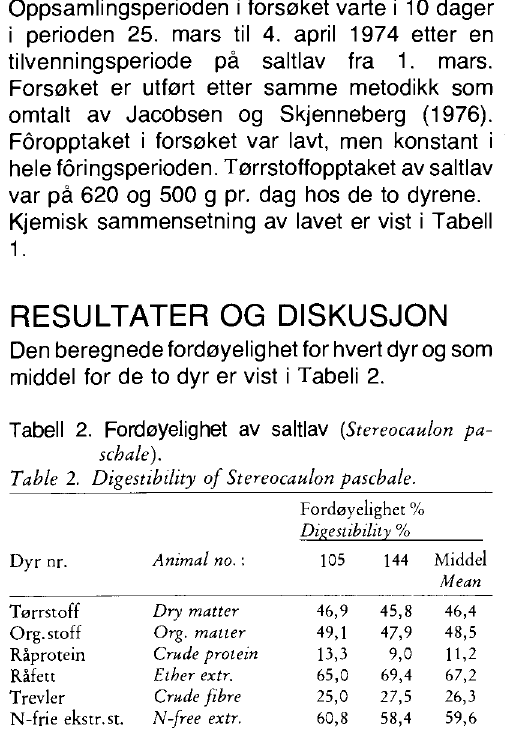
Table 2. Digestibtlity of Stereocaulon pascbale.